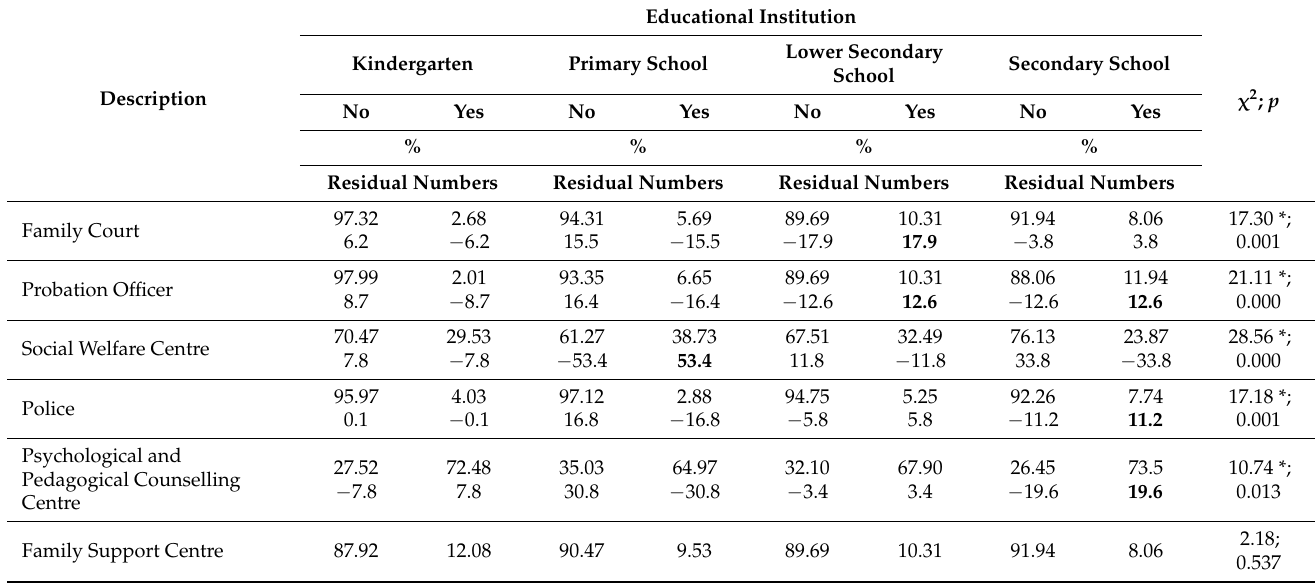
Table 5. Diversification of cooperation with institutions in the field of providing assistance to students whose parents have gone